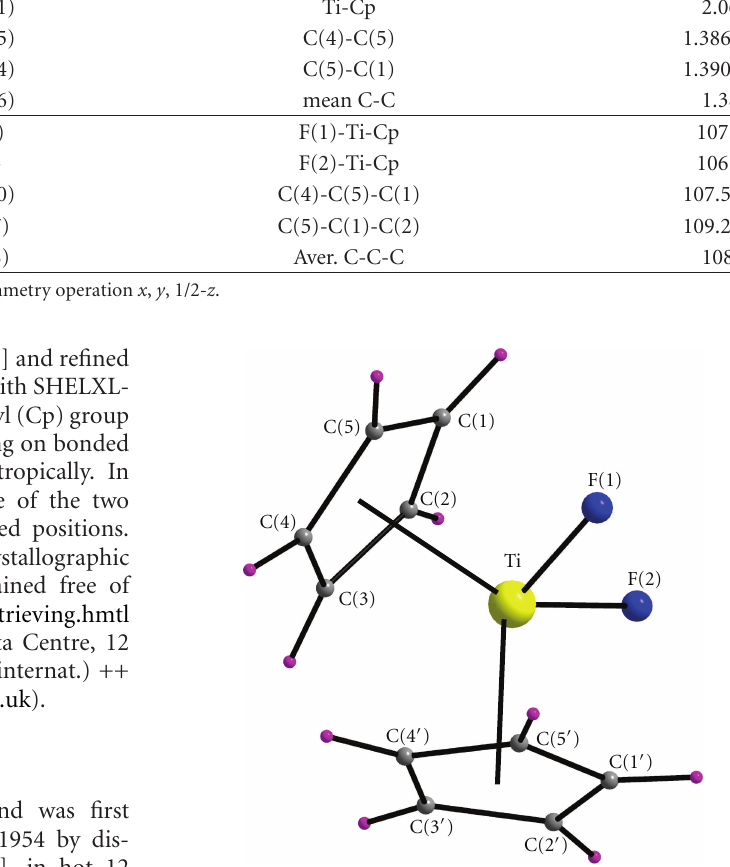
Figure 1: Labeled PovRay representation of complex 1 with the atom numbering scheme. Primes are used for symmetry-related atoms. Colour scheme: Ti IV , yellow; F, blue; C, gray; H, purple.